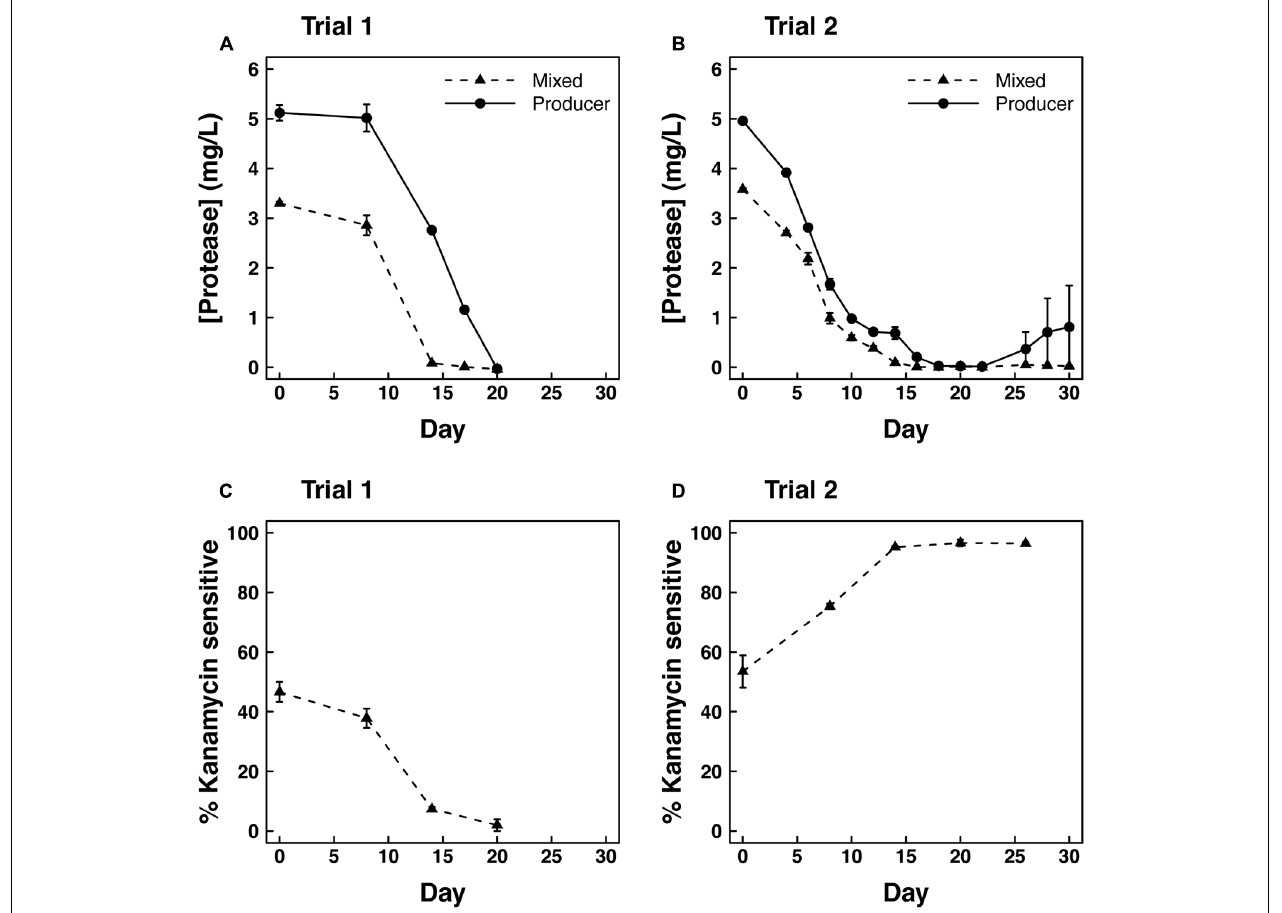
FIGURE 2 | Protease concentration (mg/l proteinase K equivalents) over time in (A)Trial 1 and (B)Trial 2 for producers grown alone or mixed (50–50%) with cheaters. Kanamycin sensitive fraction of isolated clones over time in (C) Trial 1 and (D) Trial 2 in the mixed